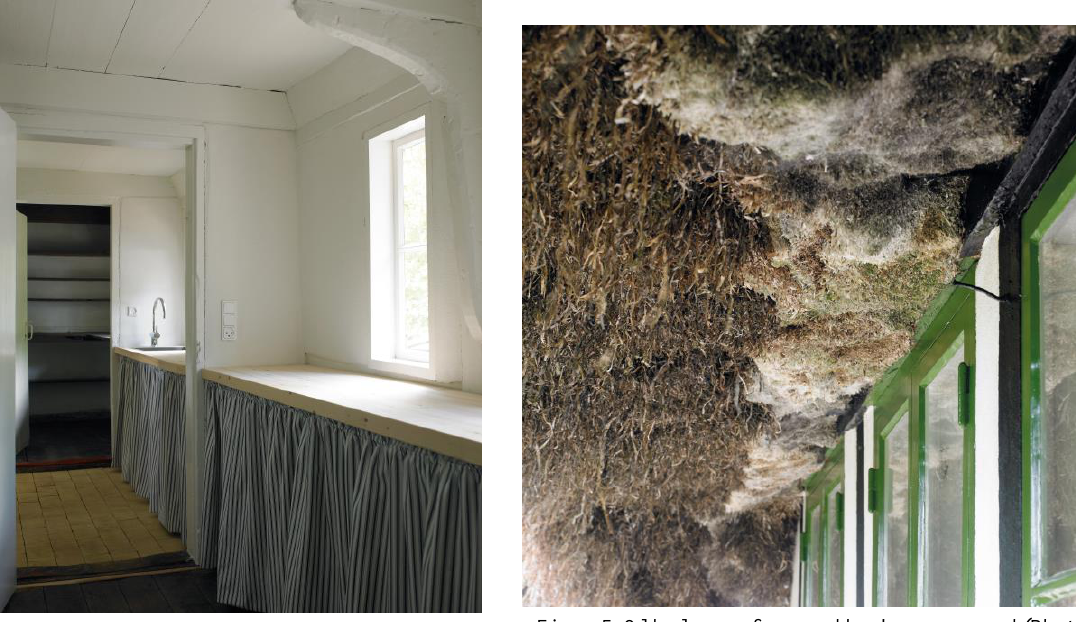
Figure 4. Scullery, kitchen and larder (Photographer Helene Høyer Mikkelsen / Realdania By & Byg).